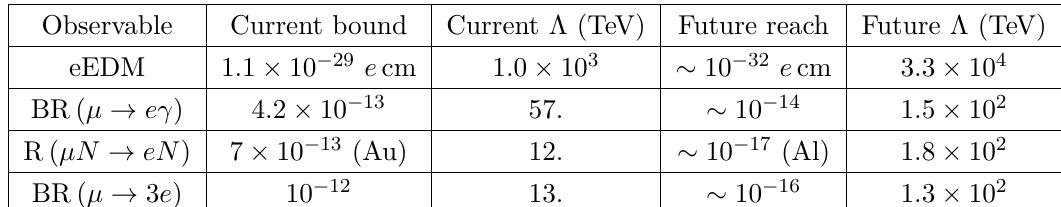
Table 1 . The current and future 90% confidence level bounds on the LFV processes and the electron EDM that we study in this work. We have also converted them each to a representative mass scale Λ by setting the coefficient of the appropriate dipole operator in eq. (2.3) to c actual mass sensitivity, of course, depends on the details of the lepton flavor model. Note that the scale Λ probed by EDMs and MDMs scales like the inverse square root of the experimental sensitivity, whereas for LFV observables it scales like the inverse one-fourth